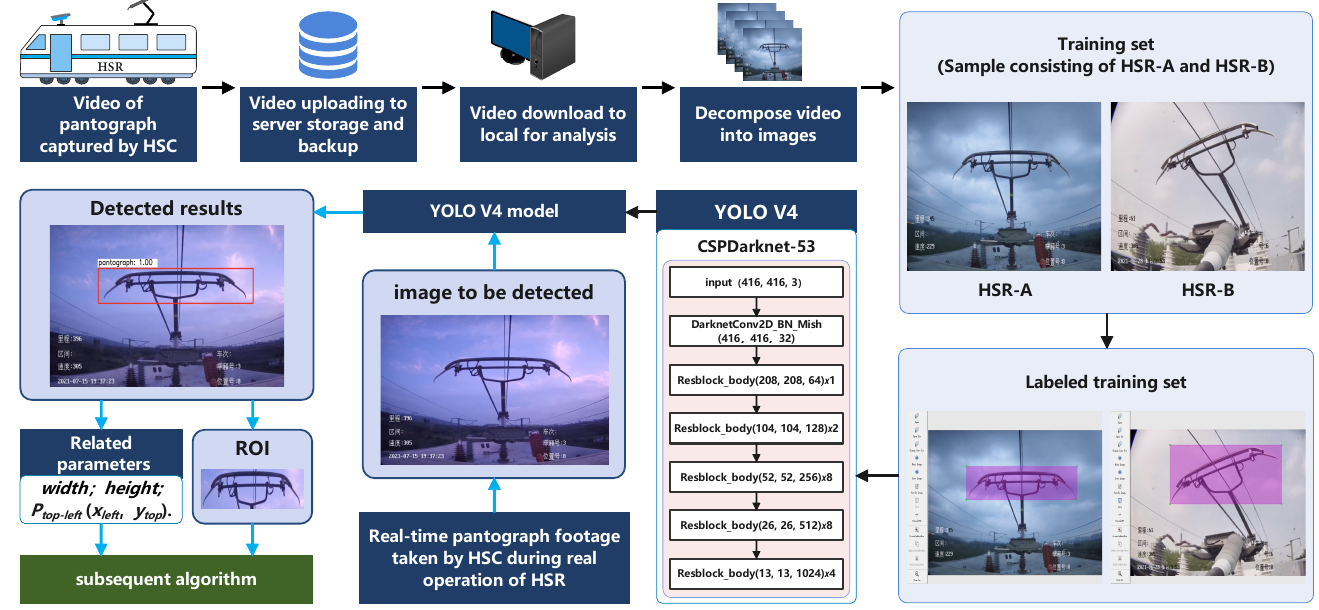
Figure 4. YOLO V4 overall algorithm